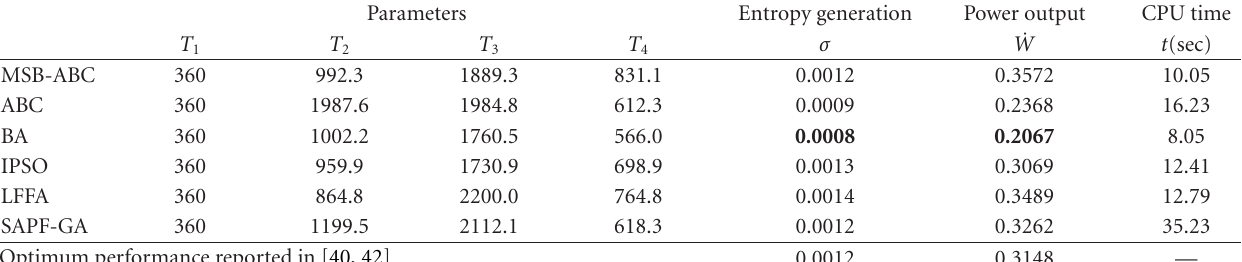
Table 5: Performance of tested algorithm in γ 0 = 1 . 36 and k 1 = 0 . 00003